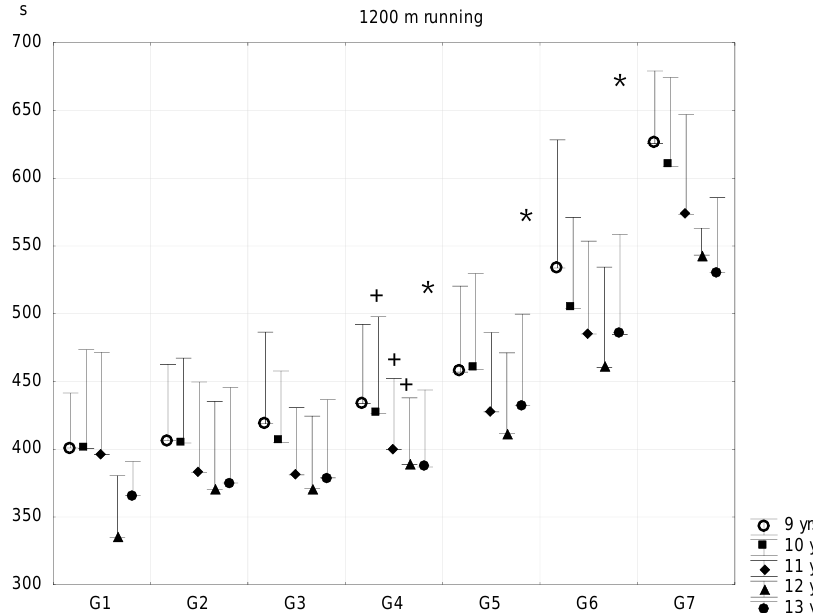
Figure 9. Relationship between body fat percentage and 1200 m running (mean + SD). 1—F% < 8.00; 2—F% = 8–11.99; 3—F% = 12.00–15.99; 4—F% = 16.00–19.99; 5—F% = 20.00–23.99; 6—F% = 24.00–27.99; 7—F% > 28; F% body fat percentage; * significant difference among subsequent groups; + significant difference in certain consecutive groups, p < 0.05.